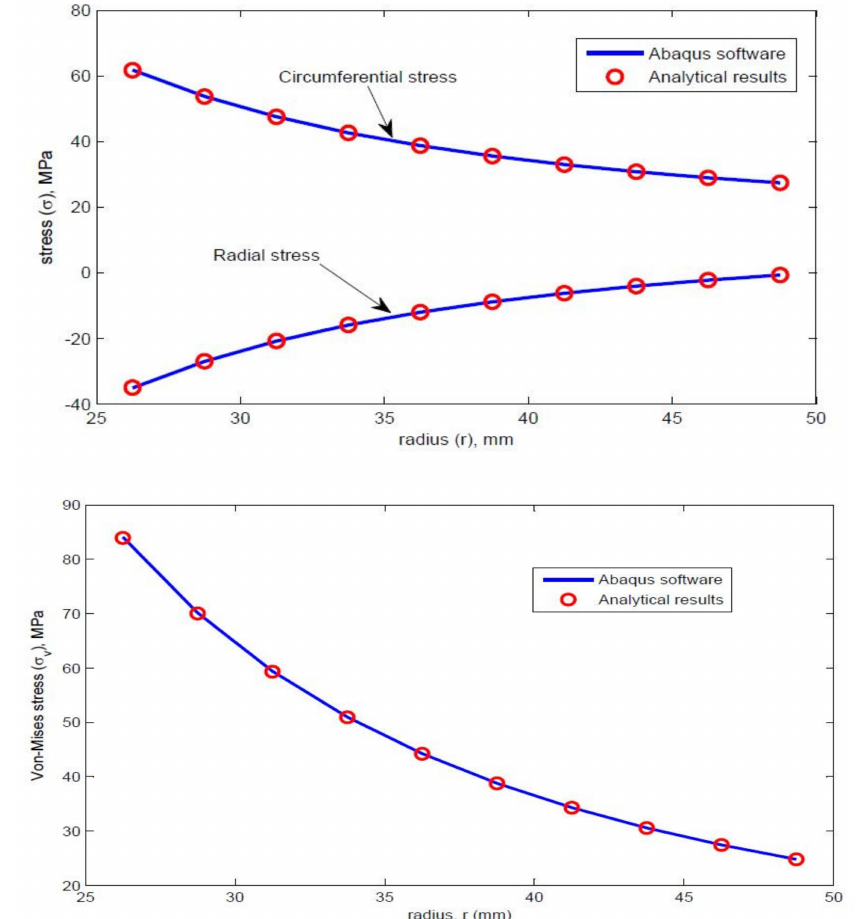
Figure 9. Radial and circumferential stress and von Mises